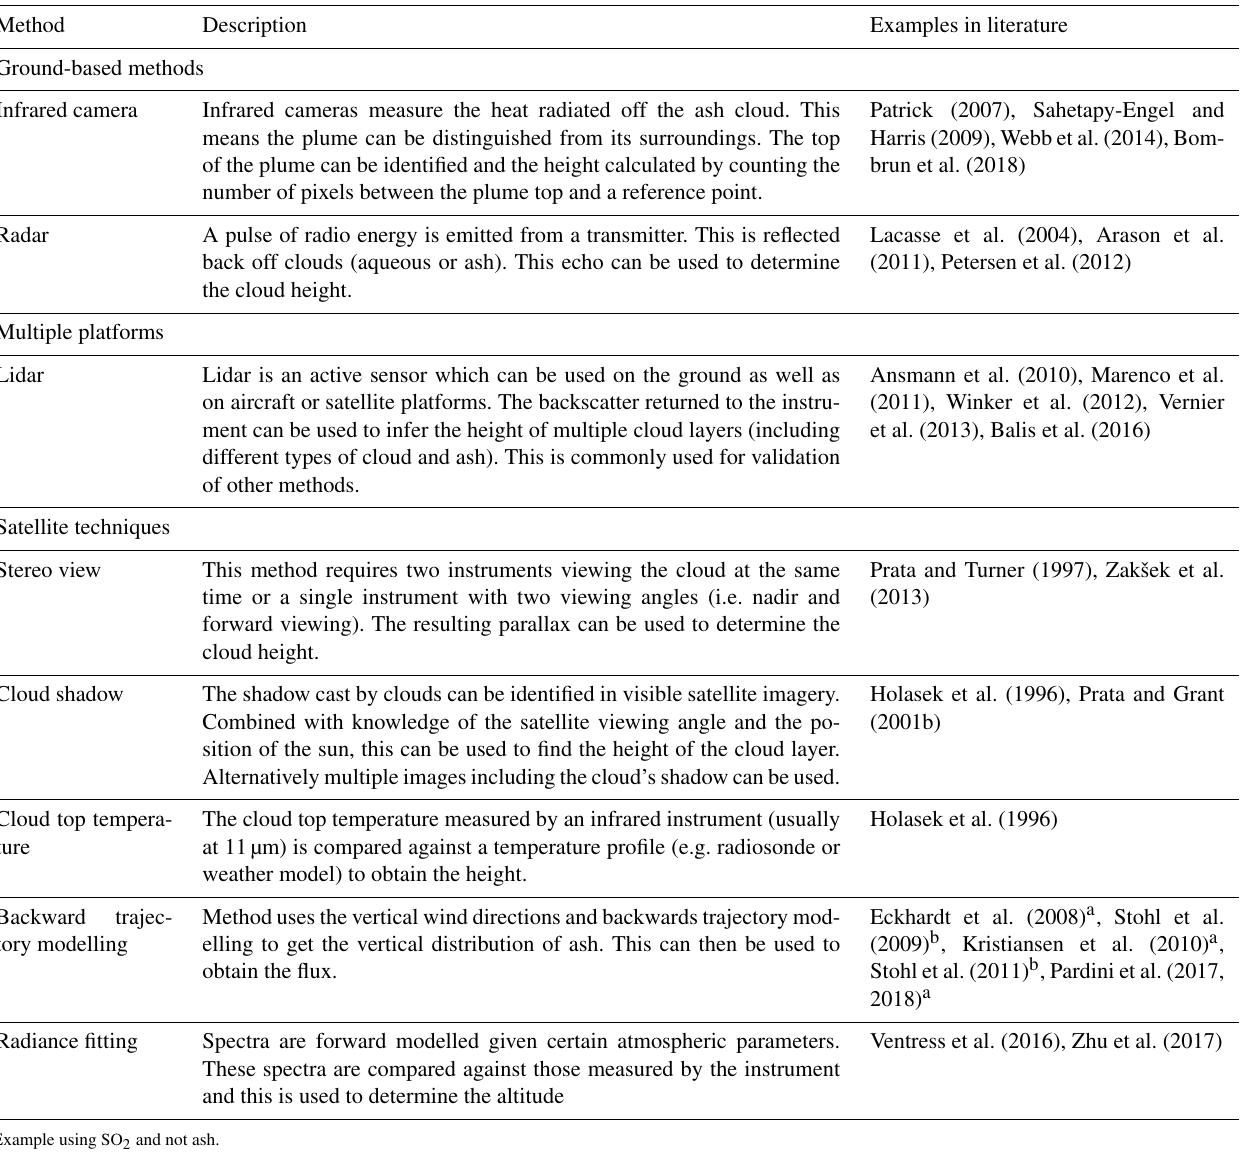
Table 1. A summary of some of the existing methods for determining the height of volcanic ash clouds. Summaries can be found in Oppen- heimer (1998), Prata and Grant (2001a), Prata and Grant (2001b), and Zakšek et al.